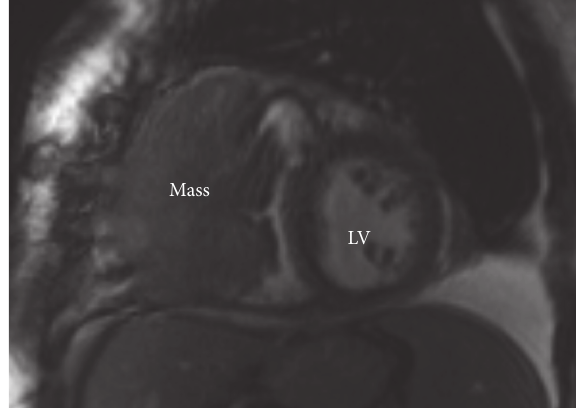
Figure 4: Cardiac MRI image showing a parasternal short axis view at the level of the papillary muscles demonstrates a large mass in the